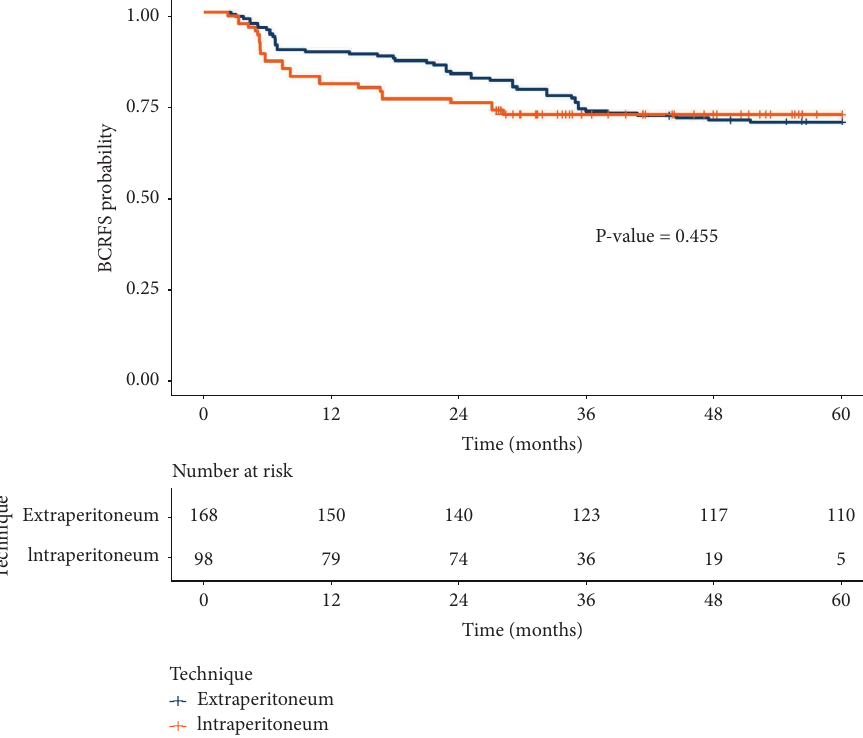
Figure 1: Kaplan–Meier survival curve of BCR-free survival postlaparoscopic radical prostatectomy between intraperitoneal and extraperitoneal